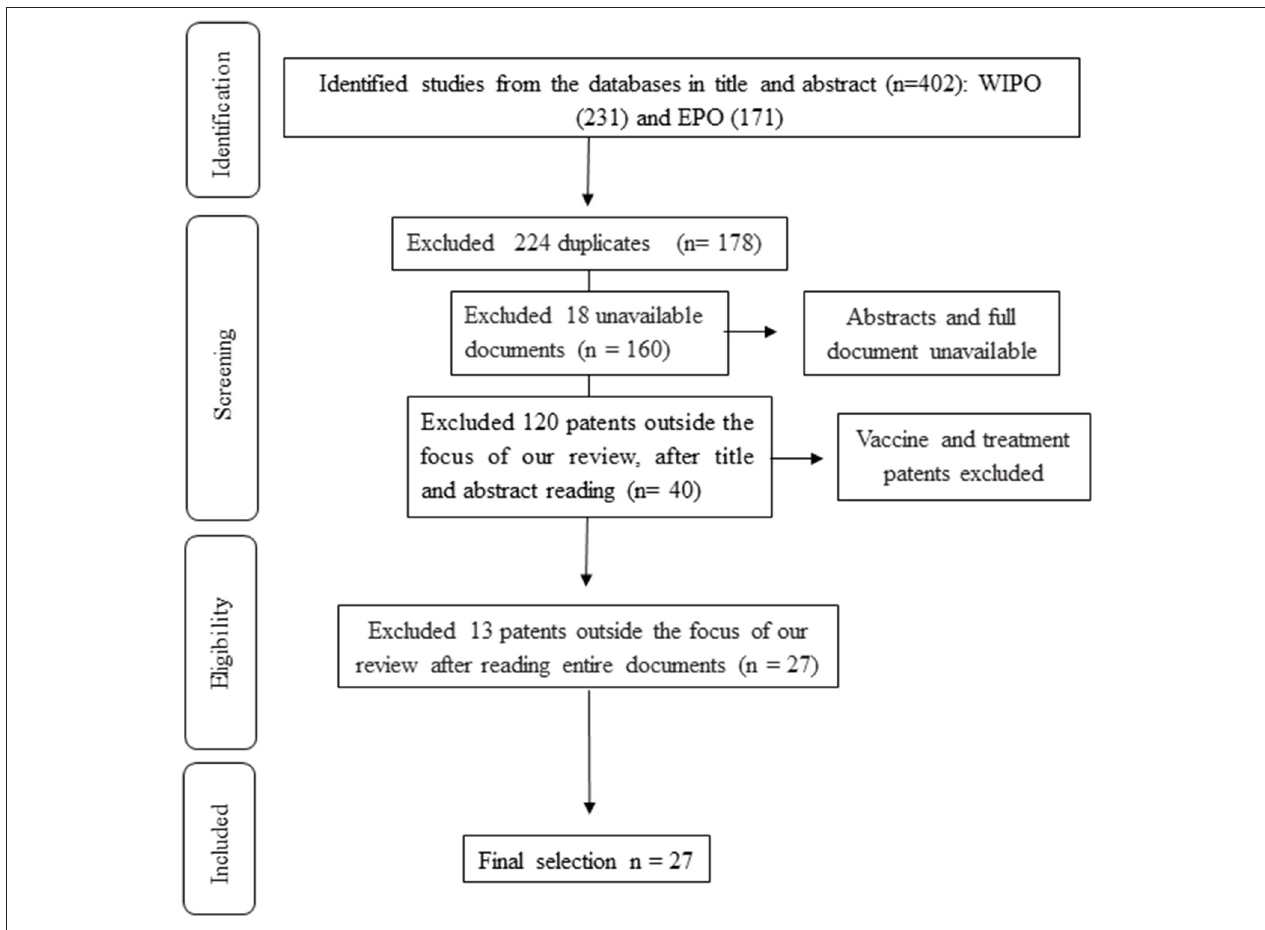
FIGURE 1 | Flowchart of patent search and